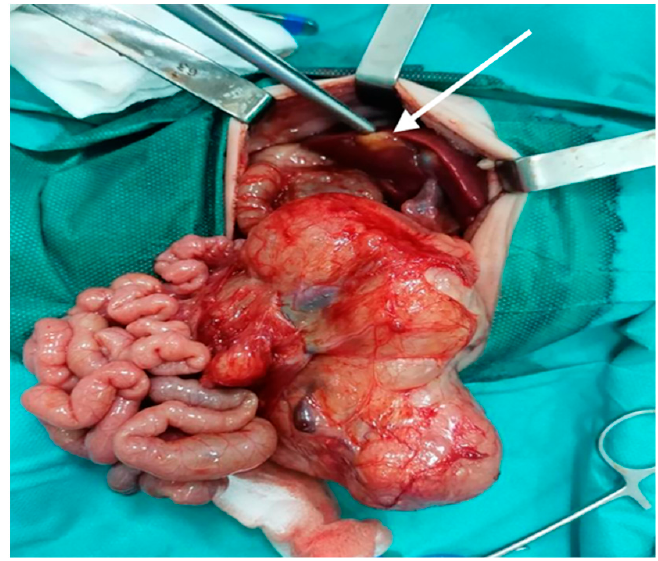
Figure 3. Intraoperative image of pancreatic hamartoma and hepatic tumor (arrow).